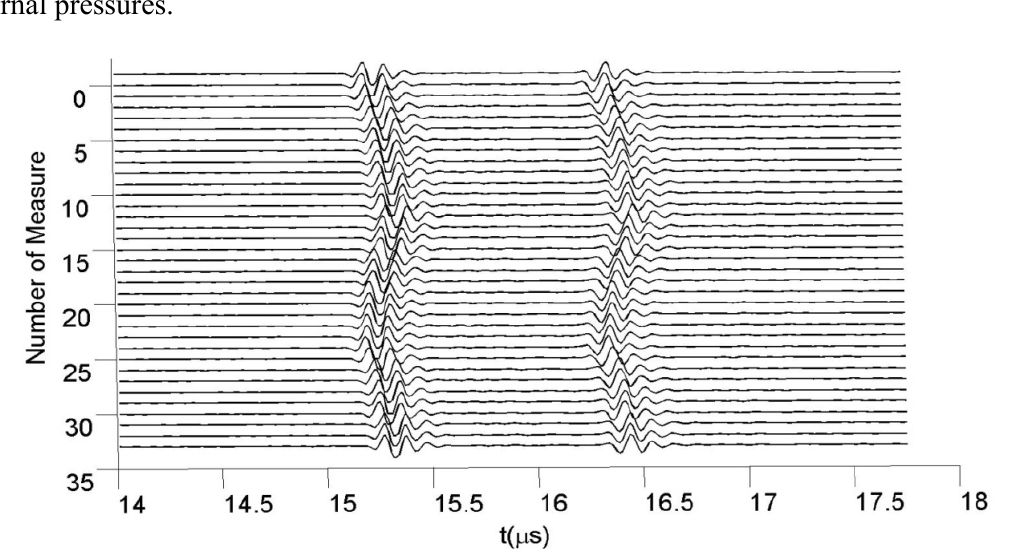
Figure 9. Thirty five time-waveforms belonging to echoes experimentally acquired from the nearest wall to transducer of an elastic latex tube, filled with water under dynamic internal